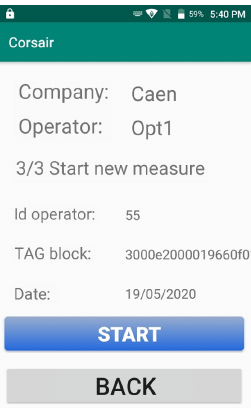
Figure 10. CORSAIR App screen after identification of sensor node and ID block, ready to start a new measurement